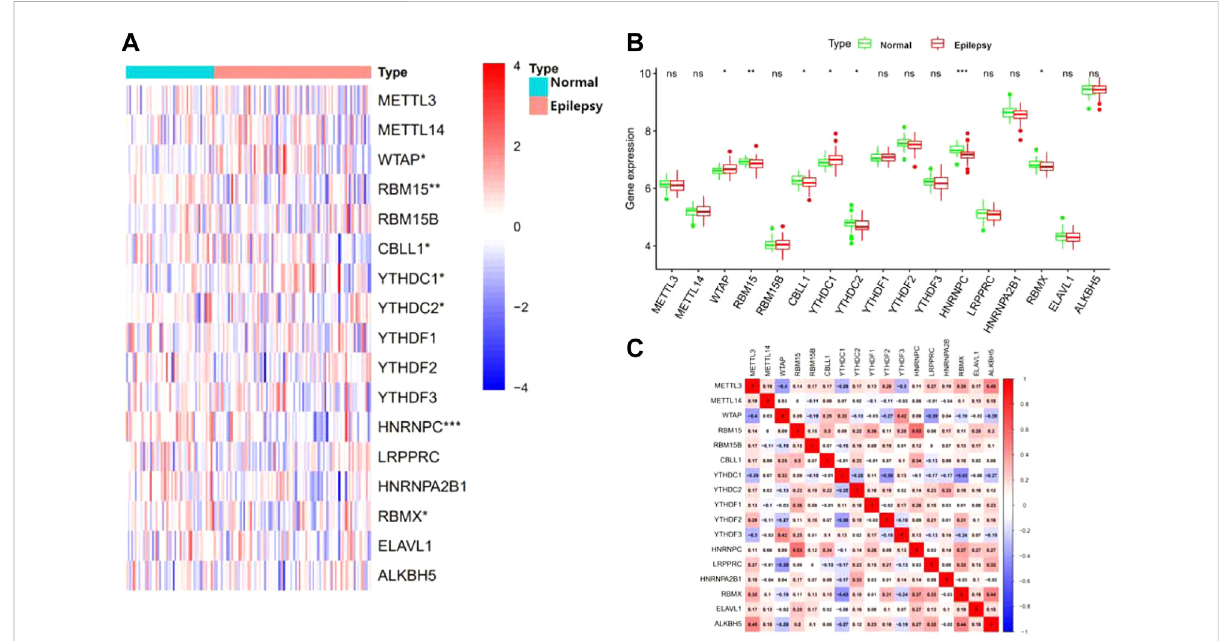
FIGURE 1 Landscape of the 17 RNA N6-methyladenosine (m6A) regulators in epilepsy. (A) Expression heat map of the m6A regulators in patients with epilepsy and healthy groups. (B) Differential expression histogram of 17 m6A regulators between non-epilepsy and patients with epilepsy.